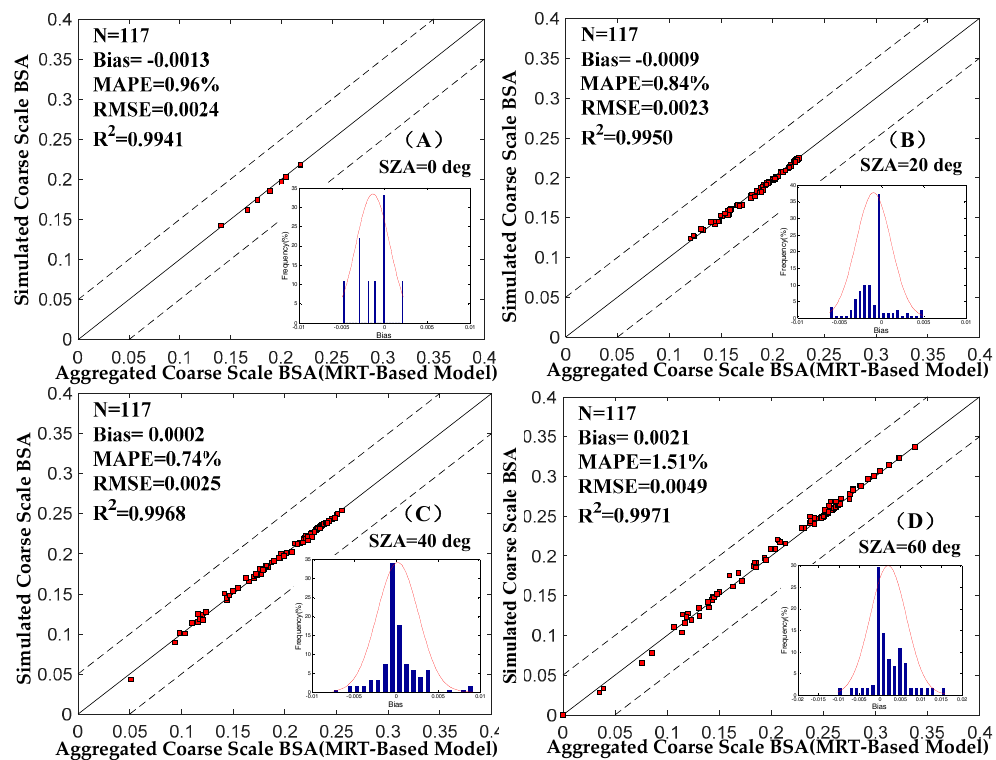
Figure 6. Validation results at different solar zenith angle: ( A ) the solar zenith angle is 0 ◦ ; ( B ) the Solar Zenith Angle (SZA) is 20 ◦ ; ( C ) the SZA is 40 ◦ ; and ( D ) the SZA is 60 ◦ .